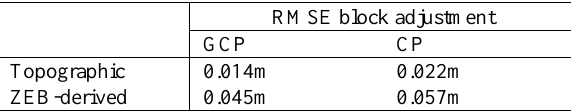
Figure 9. Orientation of the photogrammetric block. A view of the Tie Points sparse cloud and of the images position